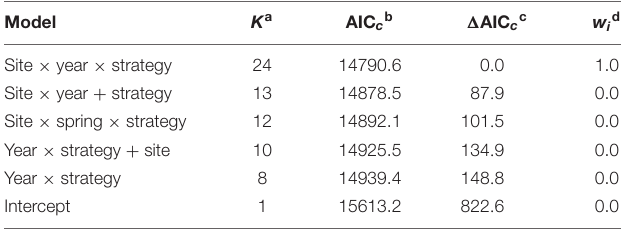
TABLE 4 | Parameter estimates from top-ranked model (site*year*strategy) explaining variation in initiation dates of shorebird nests at Utqia˙gvik, Colville River, and Prudhoe Bay,